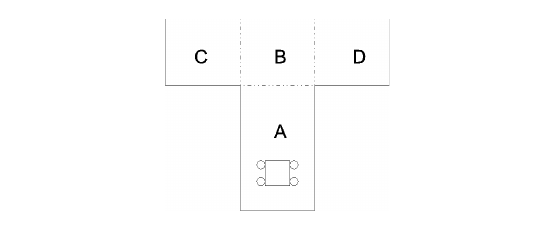
Figure 4. A simple “T” maze example to illustrate action selection problem with place cells: if food is in C and water in D, two movements (“turn left” and “turn right”) should be associated with B.